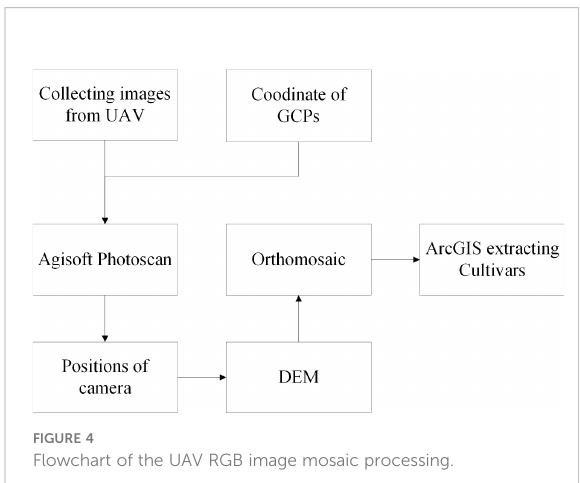
FIGURE 4 Flowchart of the UAV RGB image mosaic